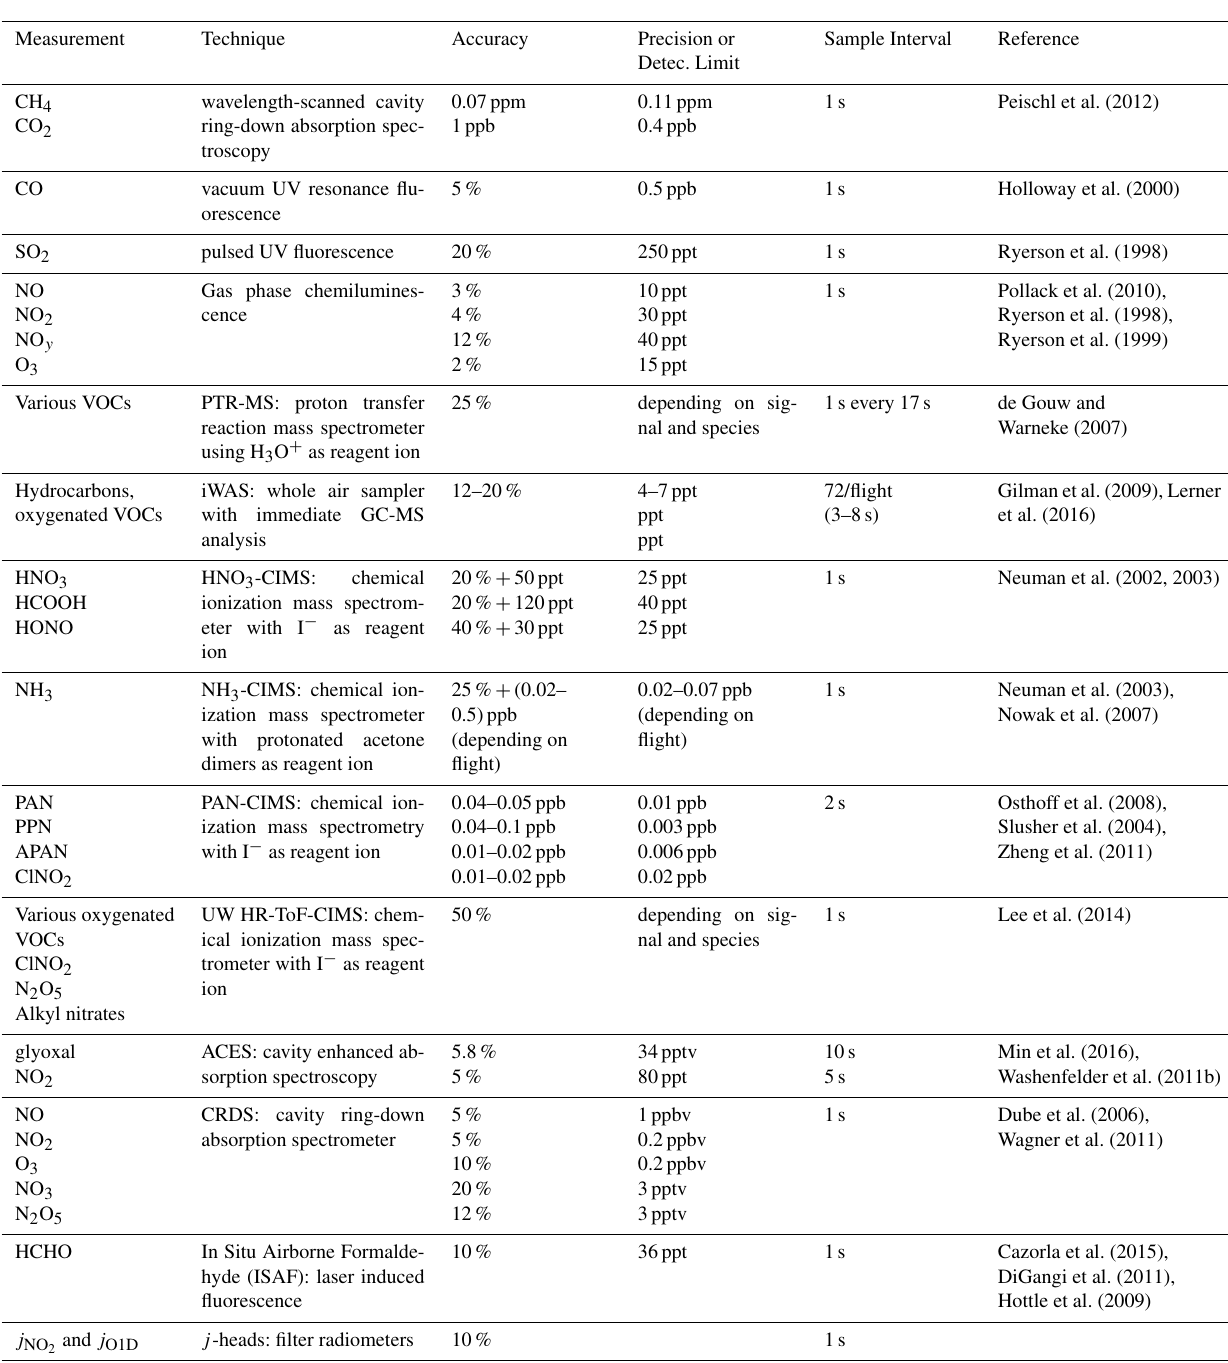
Table 6. Gas-phase instrumentation on the NOAA WP-3D during SENEX.